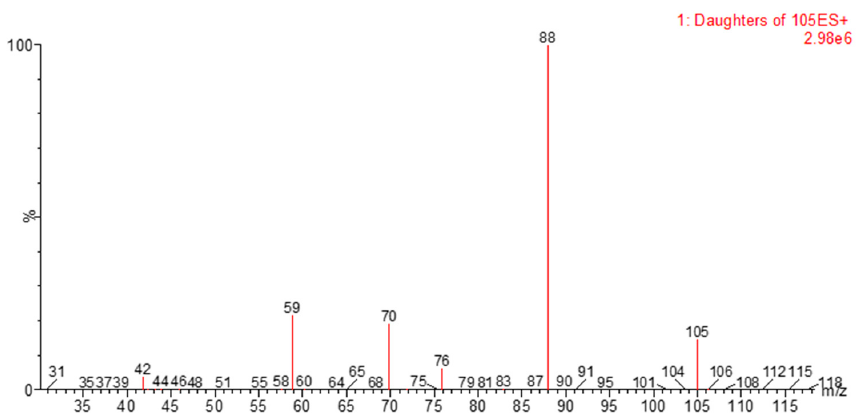
Figure 4. Collision-induced dissociation (CID) spectra of diaminopropionic acid (DAP).